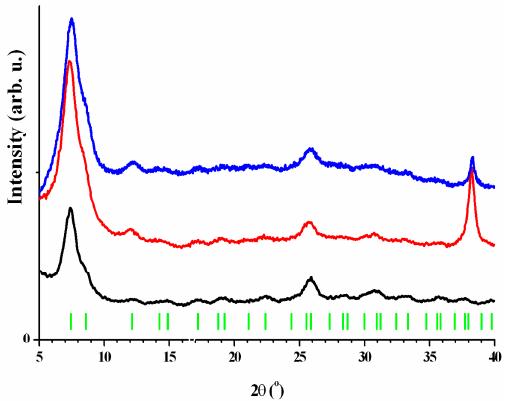
Figure 8. XRD patterns of the meso-UiO-66 (black), Au@meso-UiO-66-before-catalysis (red) and Au@meso-UiO-66-after-catalysis (blue) samples. The vertical bars denote calculated positions of the peaks for the cubic crystal structure UiO-66.